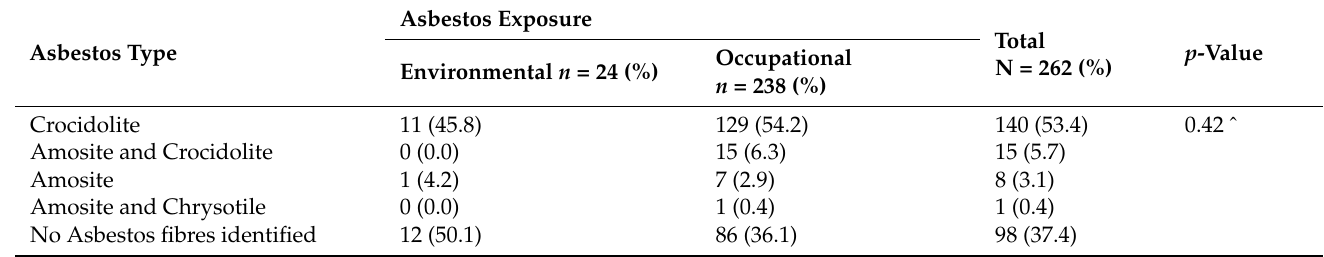
Table 3. Type of asbestos fibre among mesothelioma cases based on the pattern of exposure.